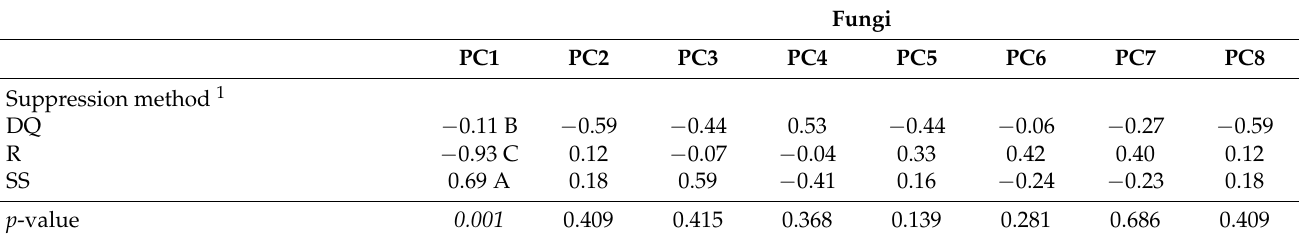
Table 5. Mean values and probability values ( p -values) associated with the analysis of variance (ANOVA) results for the effects of the suppression method on each group of principal components (PCs) calculated for fungi datasets comprised of indicator ASVs.